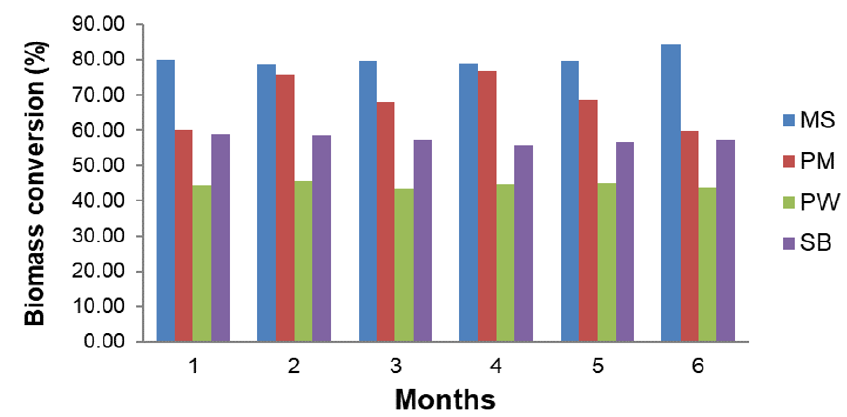
Figure 3. Biomass conversion in a laboratory.